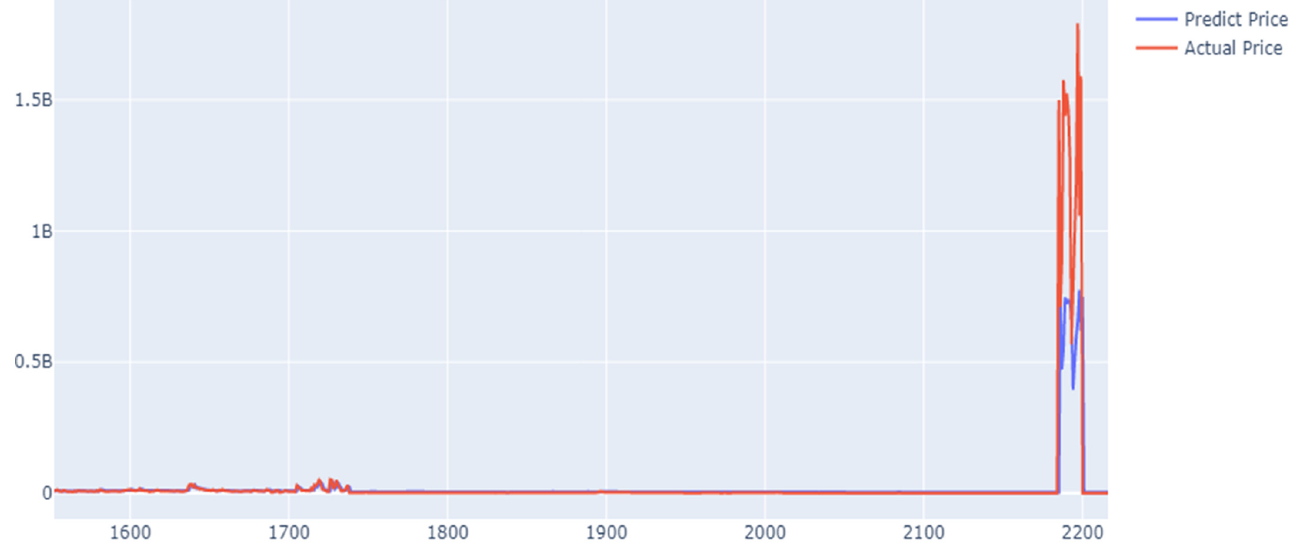
Figure 8. Time series plot of the LSTM for predicting the prices of the Ethereum cryptocurrency. An error histogram of the LSTM model’s performance in predicting the prices of the Ethereum digital currency is presented in Figure 9. The error was 6.5079 × 10 − 05 in training and 0.041537 in testing, indicating low error values.